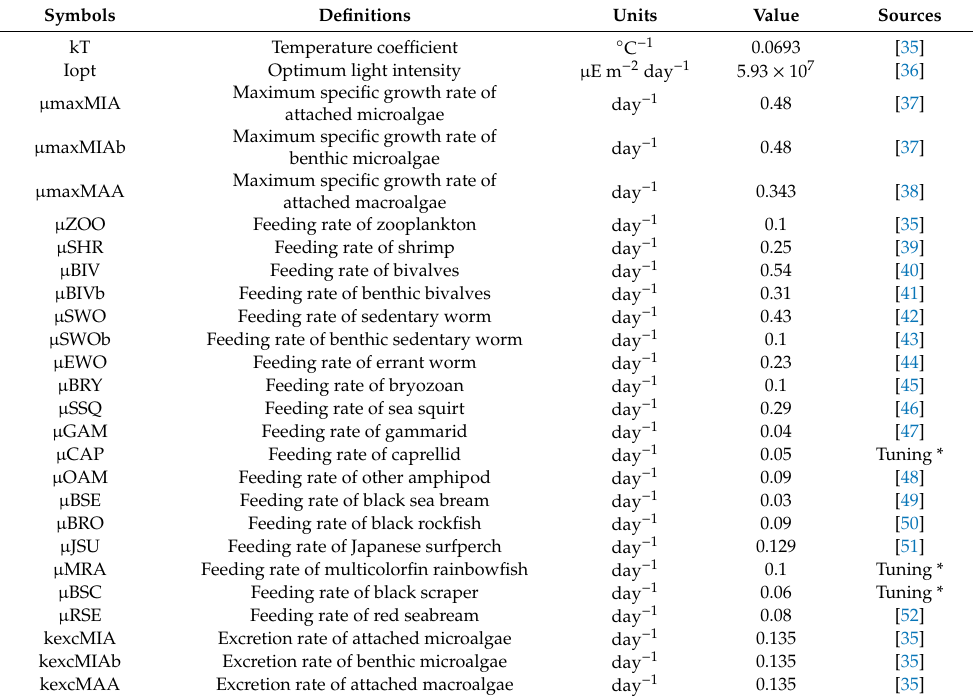
Table 3. List of parameters used in the